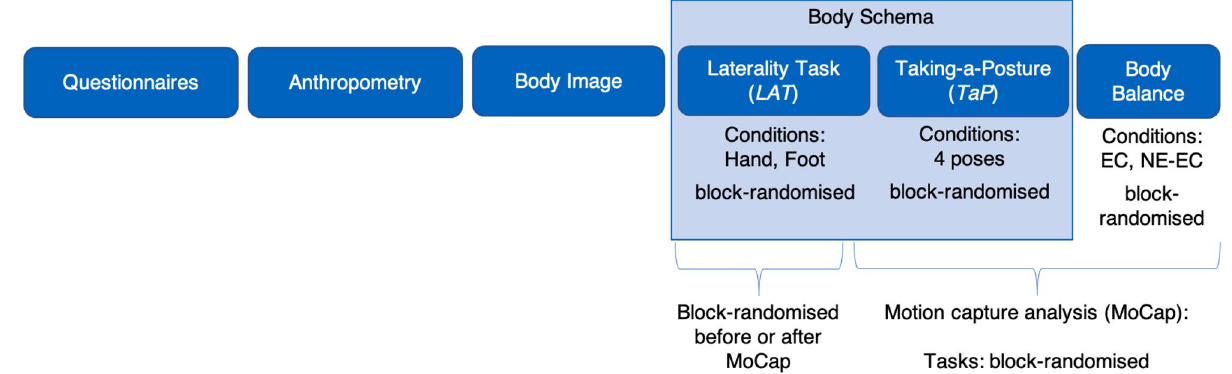
Figure 4. Experimental procedure. Balance: bipedal quiet standing with eyes closed (EC) and neck extended (NE-EC).